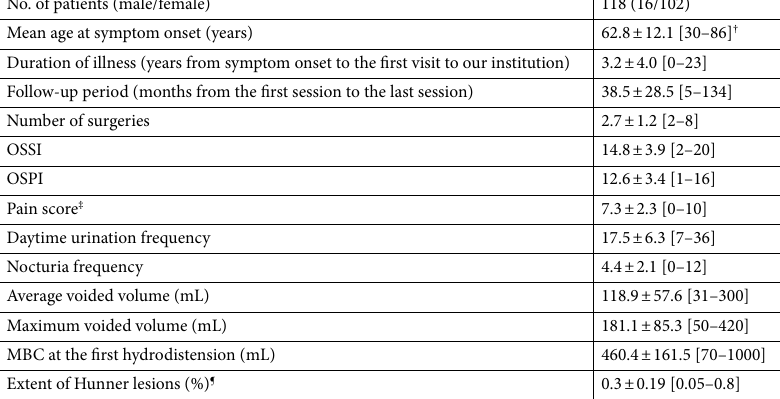
Table 1. Demographics of the study participants. MBC: maximum bladder capacity, OSSI/OSPI: O’Leary-Sant symptom index/O’Leary-Sant problem index. † Mean ± SD [range]. ‡ Assessed using an 11-point pain intensity numerical rating scale from 0, indicating no pain, to 10, indicating the worst pain imaginable. ¶ Defined as the relative bladder luminal surface area of Hunner lesions at surgery (Ref. 25